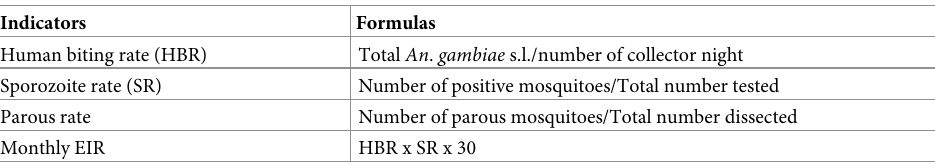
Table 1. Formulas of entomological indicators of malaria